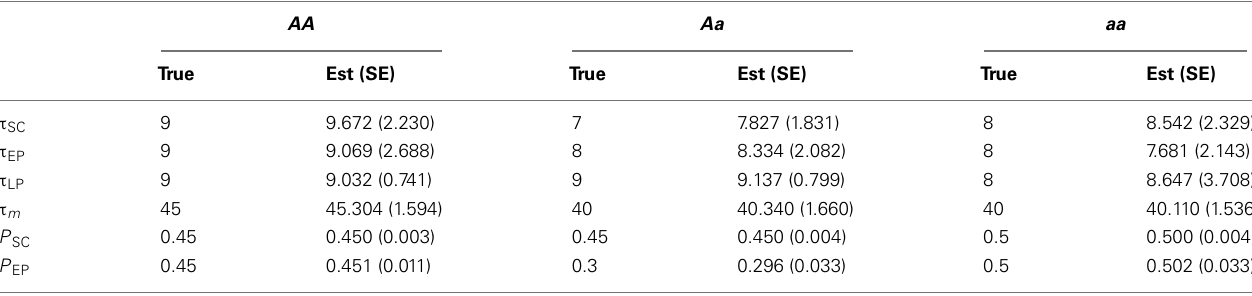
Table 2 |The estimation of parameters by a dynamic model for mapping cancer stem cell proliferation from a simulated mapping population of 500 individuals by assuming heritability H 2 =